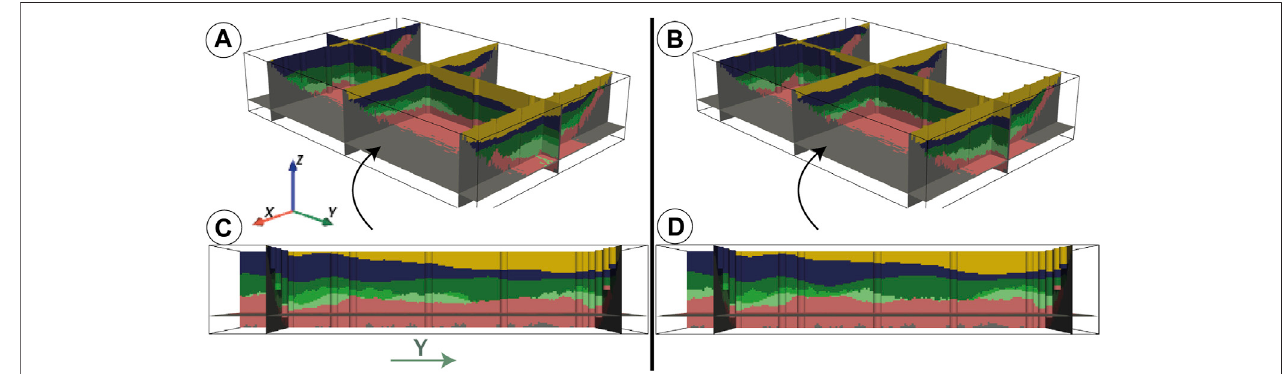
FIGURE 6 | Two realizations (A,B) of the units (1st step of the ArchPy simulations) for the synthetic case. (C) and (D) are lateral view of the realizations (A) and (B) , respectively. The colors of the units are those de fi ned in the stratigraphic pile of Figure 2 . They are presented with cross-sections for visualization purposes. Vertical exaggeration = 3x.